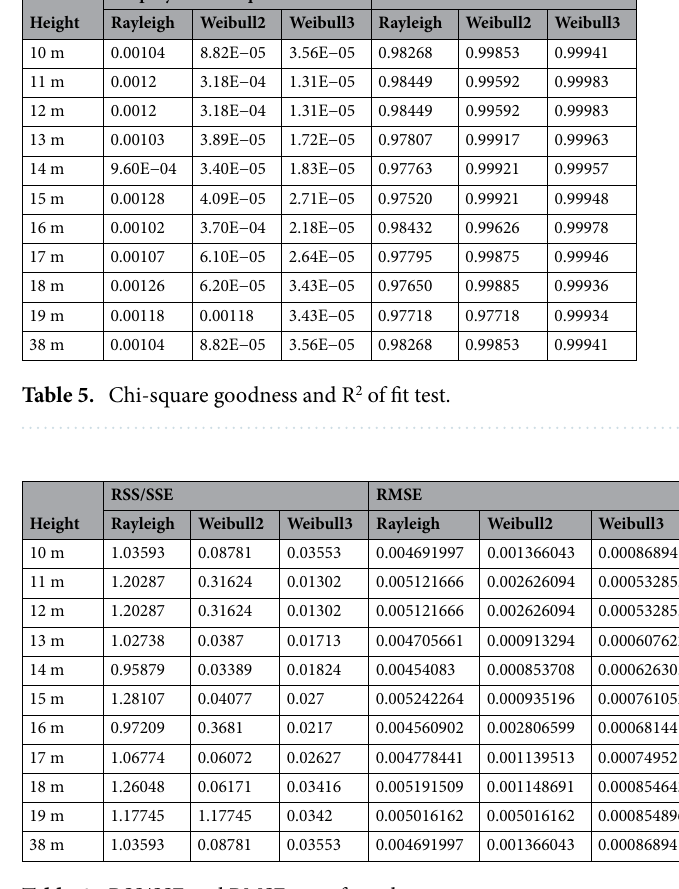
Table 6. RSS/SSE and RMSE test of goodness.